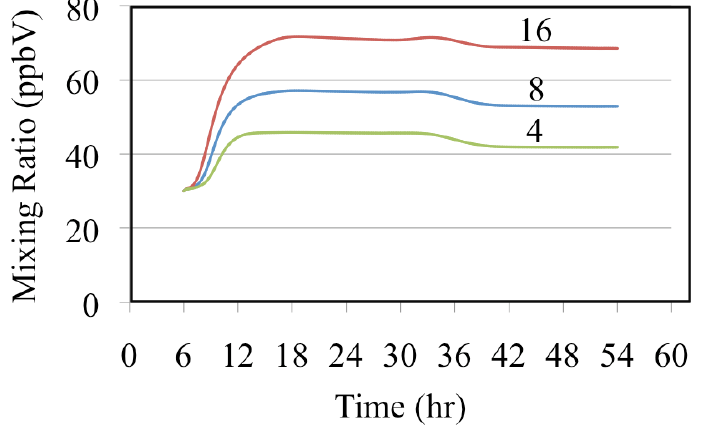
Figure 7. The CH number indicates the initial VOC/NO